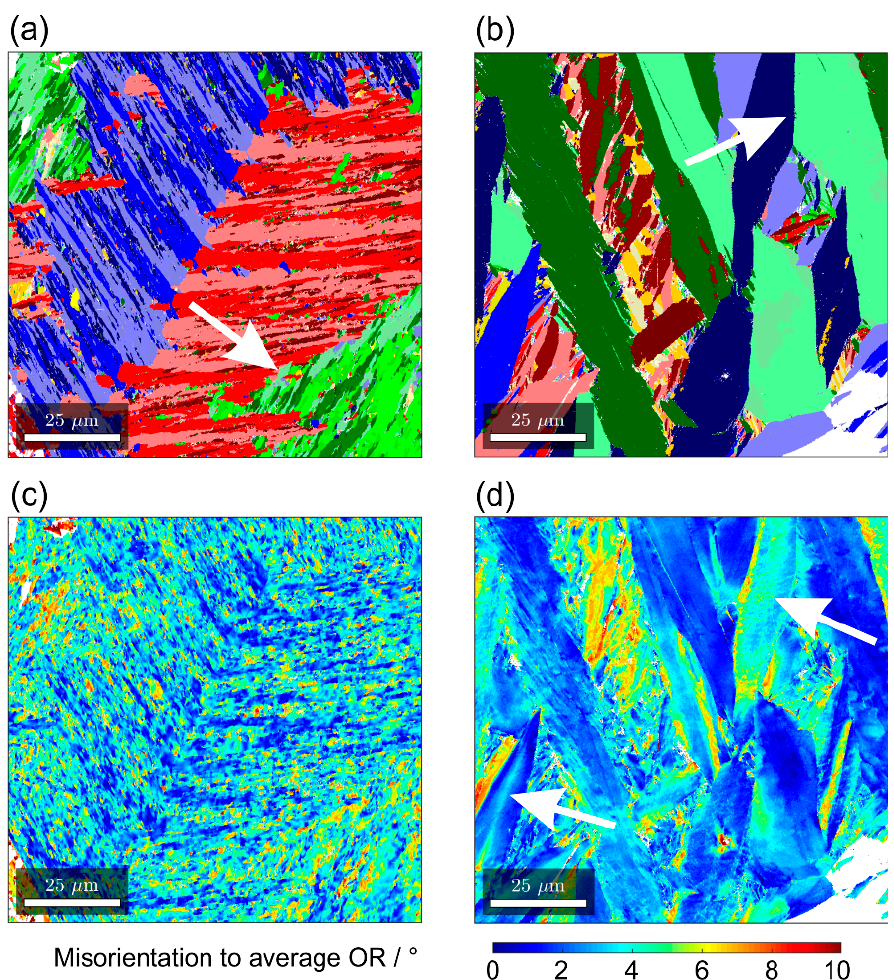
Figure 7. OI-EBSD results observed for the three types of martensite microstructures described in the present work. ( a , b ) Color-coded presentations of variant microstructures (see Figure 6d). ( c , d ) Color-coded representation of misorientation angles between measured and average MV orienta- tions. ( a , c ) Lath martensite observed in Fe-27.5Ni. ( b , d ) Plate martensite observed in Fe-29.5Ni.